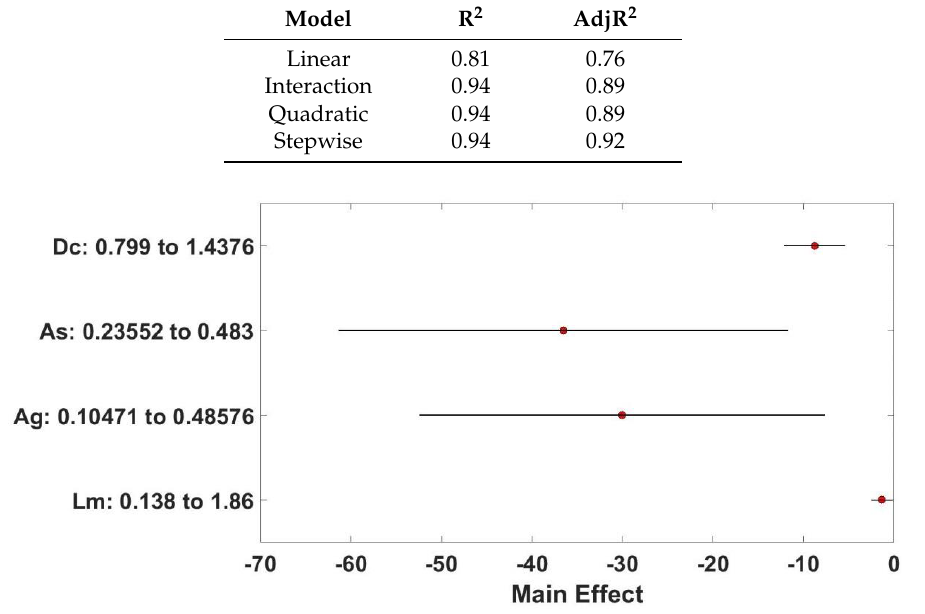
Table 5. Summary of R 2 and adjusted R 2 for each model.